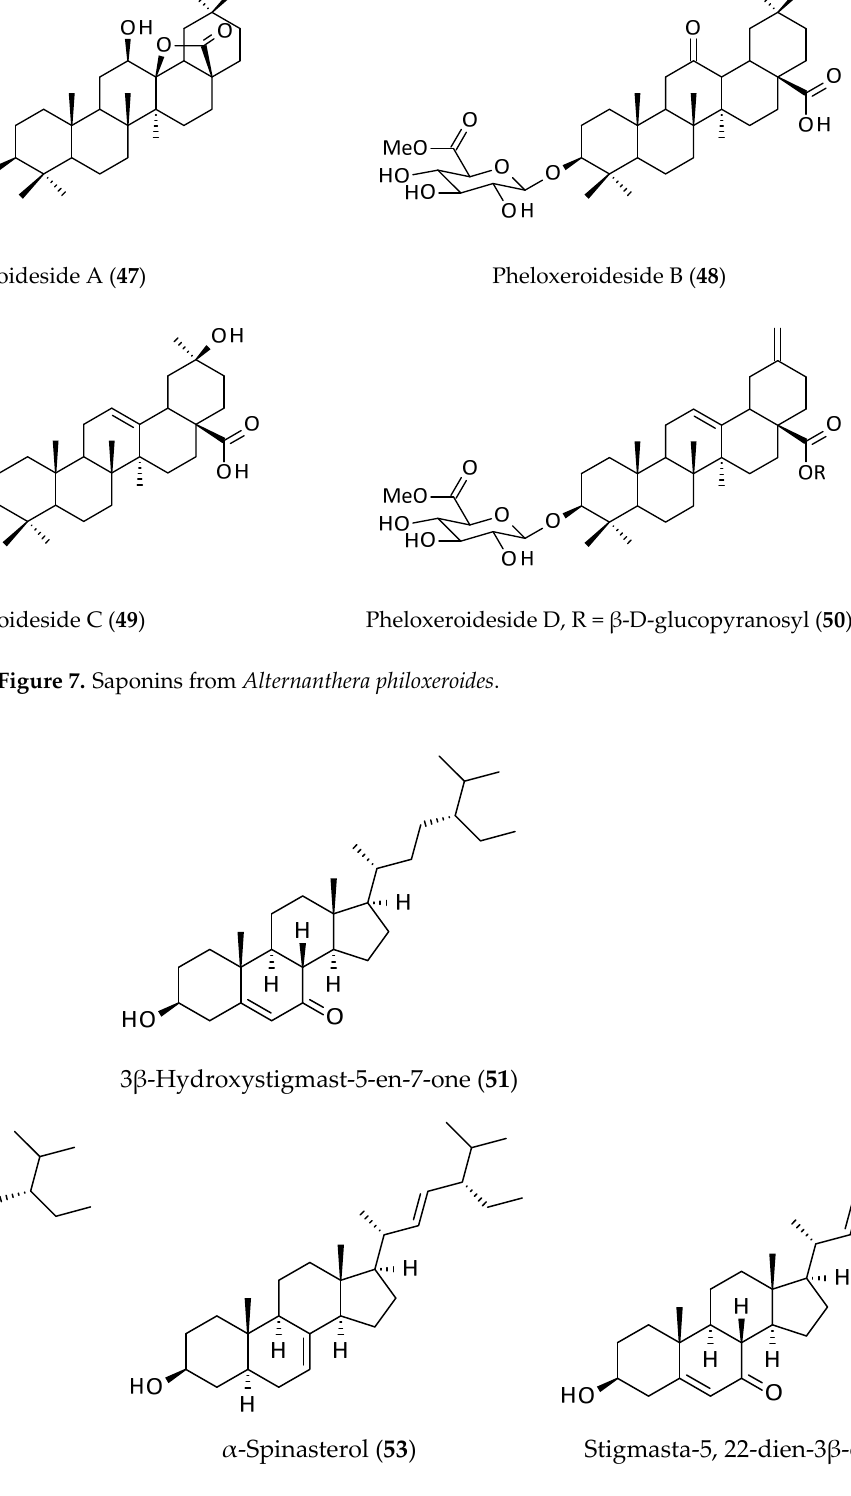
Figure 8. Steroids from Alternanthera philoxeroides .